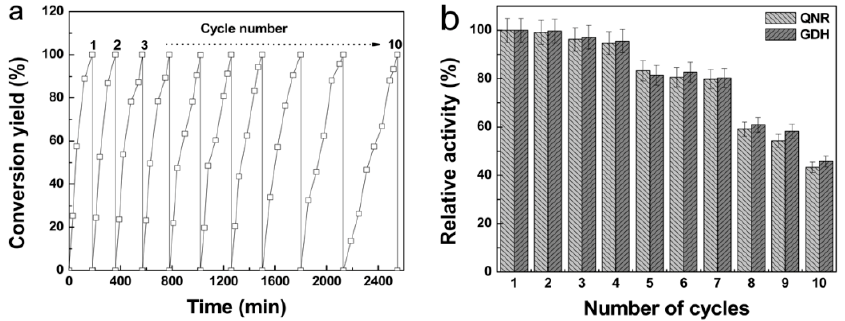
Figure 9. Reusability of magnetic combi-CLEAs for the bioreduction of 3-quinuclidinone into ( R )-3-quinuclidinol, ( a ) conversion yield of 3-quinuclidinone and ee of ( R )-3-quinuclidinol; ( b ) relative activity of QNR and GDH in magnetic combi-CLEAs.